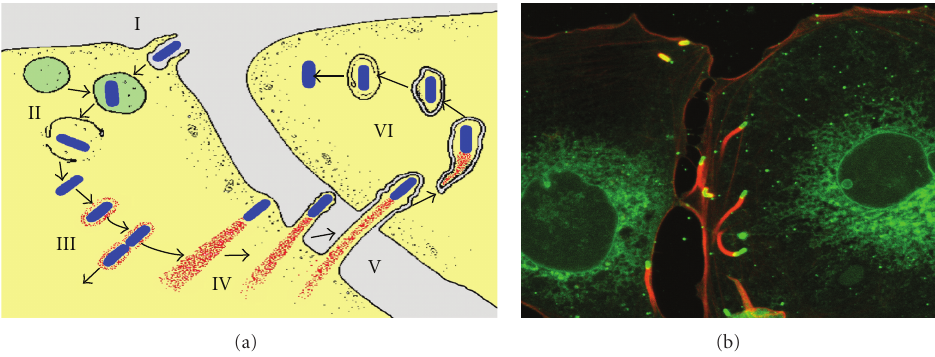
Figure 1: Stages in the intracellular life cycle of L. monocytogenes . The cartoon (a) sketches the di ff erent stages of L. monocytogenes infection: (I) cell entry mediated by invasion factors InlA or INLB, (II) escape from phagolysosom by LLO and PlcA, (III) actin recruitment and replication, (IV) intracellular movement due to polarized actin-polymerization mediated by ActA, (V) cell-to-cell spread by formation of listeriapods, and (VI) subsequent lysis of the two-membrane vacuole by LLO and PlcB. Modified from Tilney & Portnoy [12]. The fluorescence image (b) shows the intracellular movement and cell-to-cell spread of L. monocytogenes cells (green) driven by the polarized polymerization of actin tails